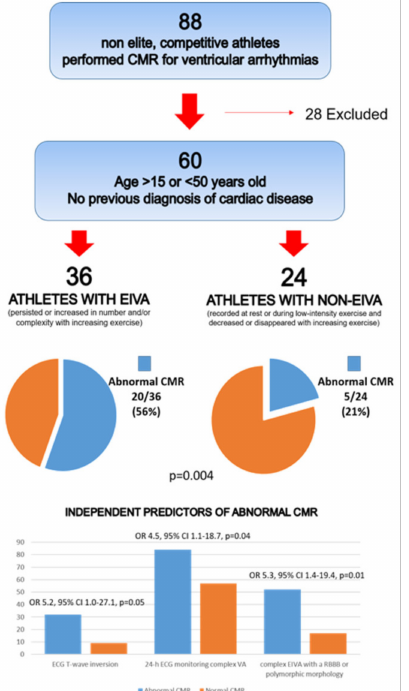
Figure 3. CMR: cardiac magnetic resonance; EIVA: exercise-induced ventricular arrhythmias; ECG: electrocardiogram; VA: ventricular arrhythmias; RBBB: right bundle branch block. Reproduced with permission from